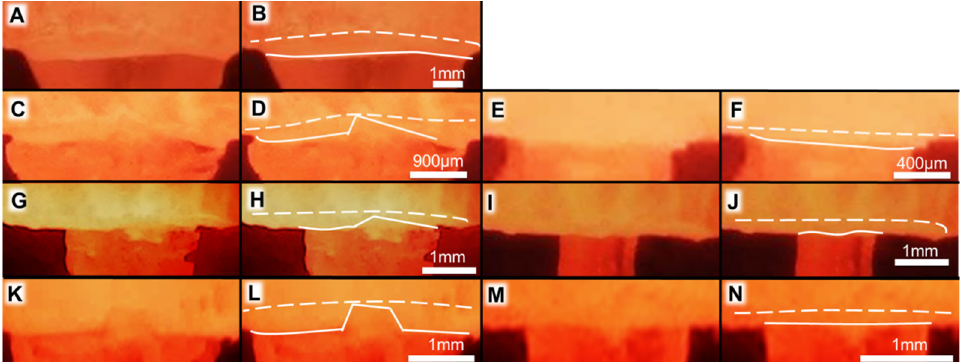
Figure 6. Interfaces between SBO crystals and melt just below a nozzle. ( A , B ): 70.6 K/mm, 0 V/cm; ( C , D ): 55 K/mm, 1000 V/cm (melt: +; growth: − ); ( E , F ) 55 K/mm, 1000 V/cm (melt: +; growth: − ); ( G , H ) 75 K/mm, 400 V/cm (melt: +; growth: − ); ( I , J ) 75 K/mm, 400 V/cm (melt: +; growth: − ); ( K , L ) 73.4 K/mm, 1000 V/cm (melt: − ; growth: +); ( M , N ) 73.4 K/mm, 1000 V/cm (melt: +; growth: − ). ( B , D , F , H , J , L , N ) were the same as ( A , C , E , G , I , K , M ) respectively, and were emphasized on the interfaces. ( C – F ) correspond to the data in our previous study, which grew along the b -axis [23]. Solid and dashed lines show outlines of the interface between the SBO crystals, melt, and the noz- zle.